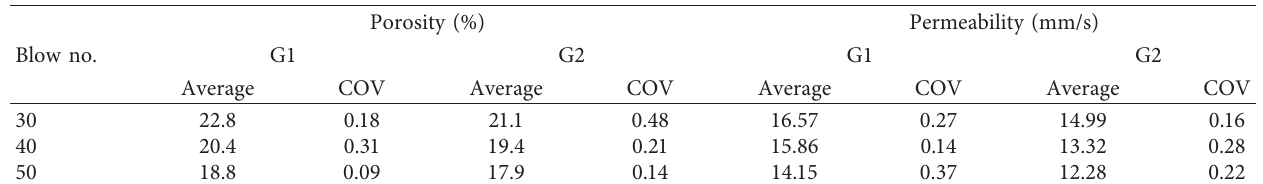
Table 2: Porosities and permeabilities of SGC specimens.